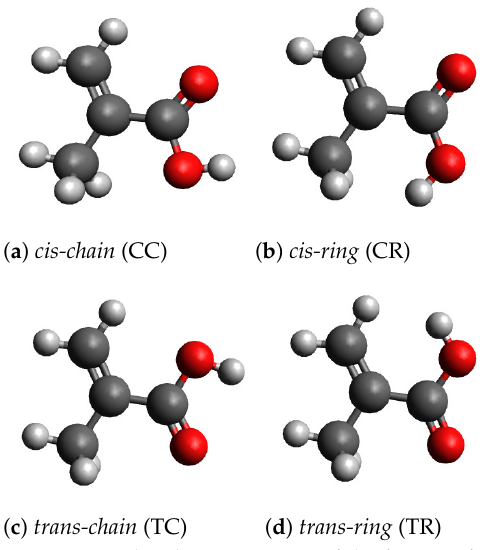
Figure 1. Molecular geometries of the four conformers. Table 1. Symmetry groups and relative total electronic energies ( ∆ E elec ), enthalpies ( ∆ H ) and Gibbs free enthalpies ( ∆ G ) of the four conformers of MAA. All values are given in kJ/mol. The values of the most stable conformer (TC) is set to zero. ∆ H and ∆ G are calculated at a temperature of 298.150 Kelvin and a pressure of one atmosphere.